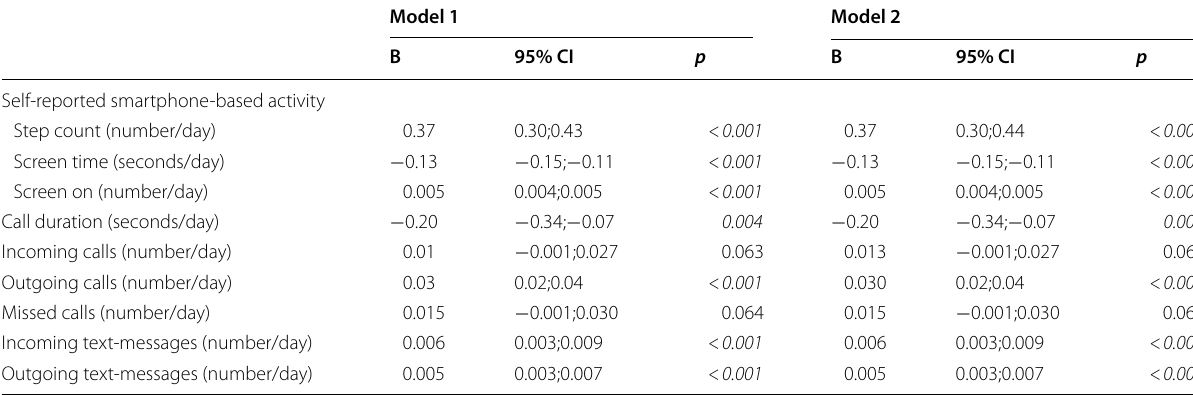
Significant p values are given in italic Model 1 unadjusted, Model 2 adjusted for age and sex.